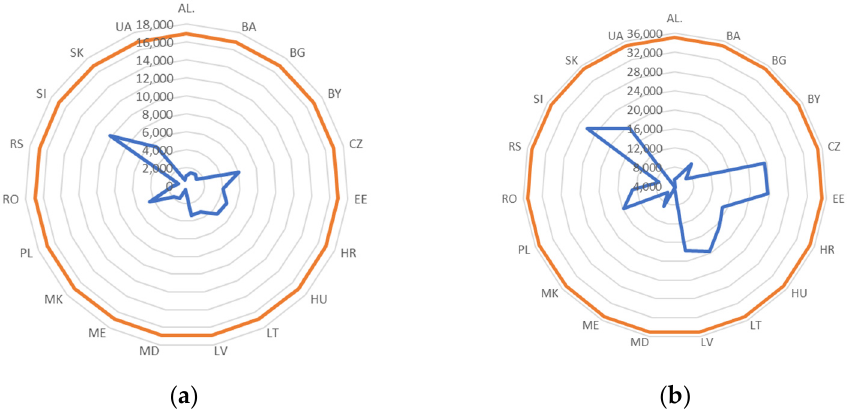
Figure 1. GDP for EU-28 and CEE countries in ( a ) 2000 and ( b ) 2019. Red line—GDP in EU-28, blue line—GDP in CEE countries.